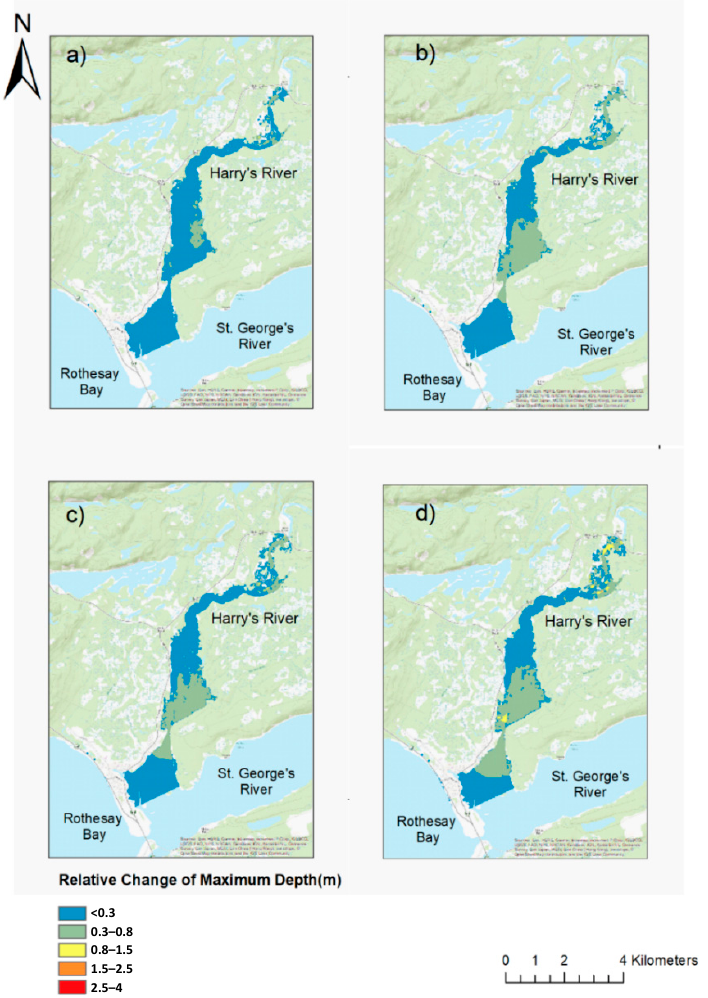
Figure 9. Projected changes in maximum flood depths corresponding to a 25-year event between the future (2080s) and historical periods: ( a ) GCM-IDF and RCP4.5, ( b ) WRF-IDF and RCP4.5, ( c ) GCM-IDF and RCP8.5, ( d ) WRF-IDF and RCP8.5.